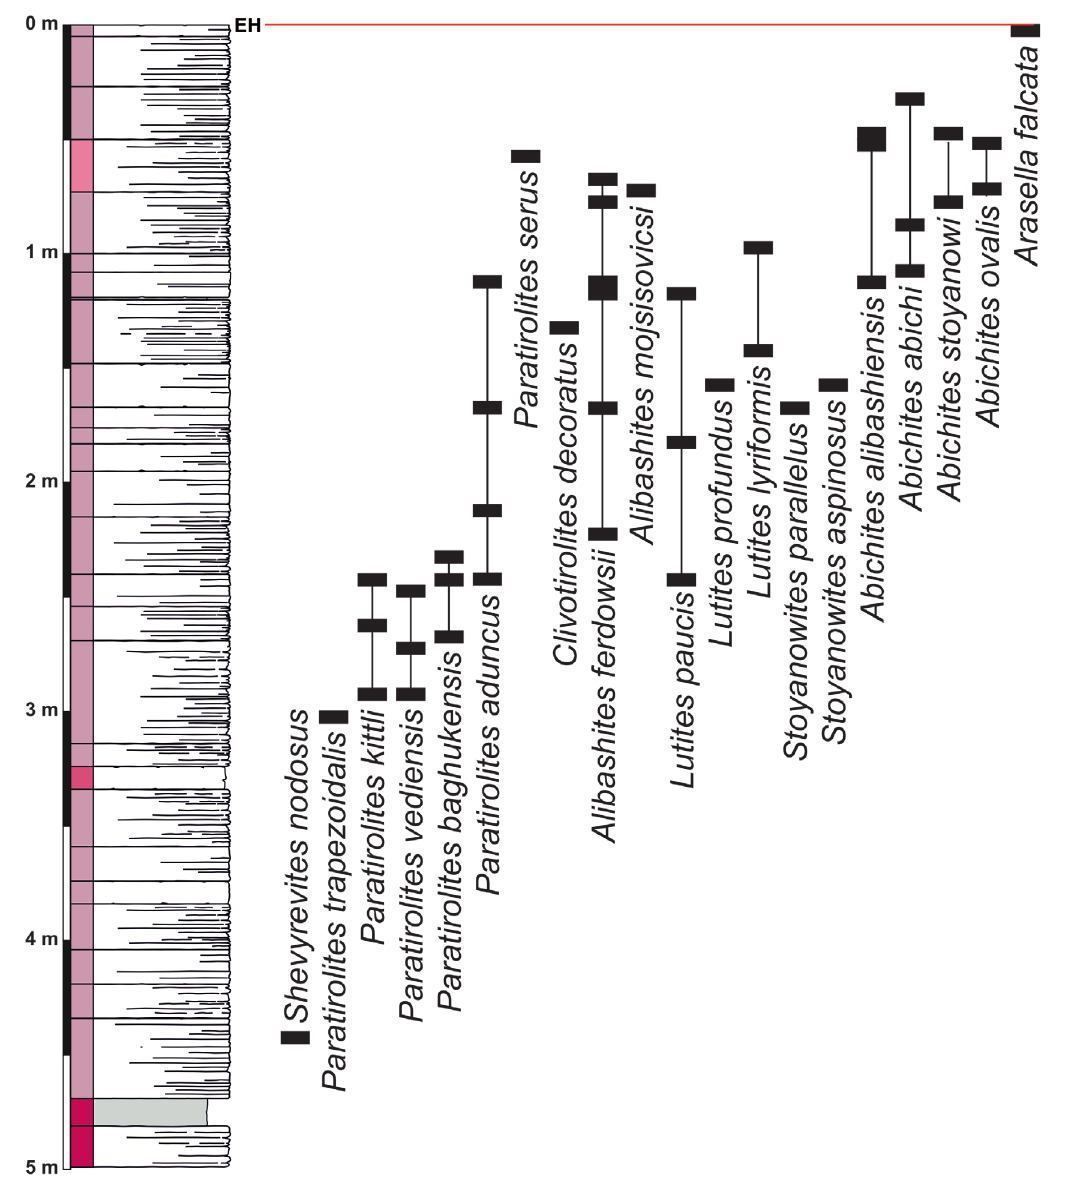
Fig. 6. The stratigraphic occurrence of the ammonoid species in the upper part of the Hambast Formation at Baghuk Mountain C section. EH =